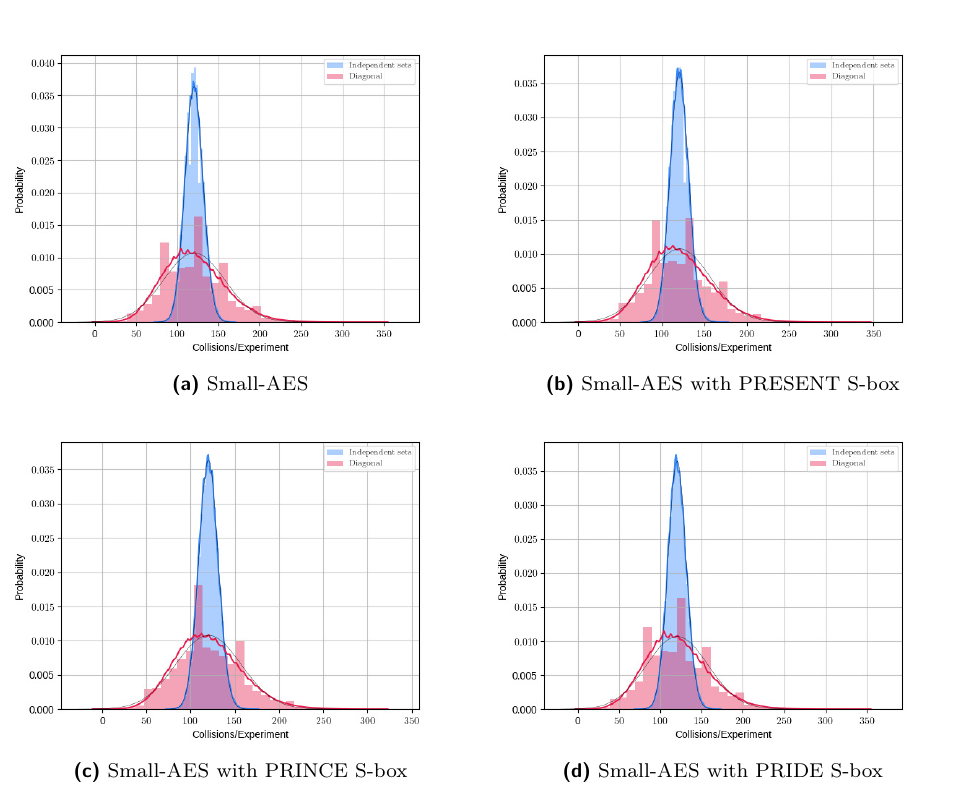
Figure 14: Distribution of the number of collisions in the first cell after five rounds in both settings, with the final MixColumns operation omitted. Both distributions used 100 000 random keys and counted the collisions from 2 14 δ -sets per key that were independent in Setting (1) or the 2 14 δ -sets from D . Thin lines are fitted normal distributions, thick lines the best fitted { 0 }